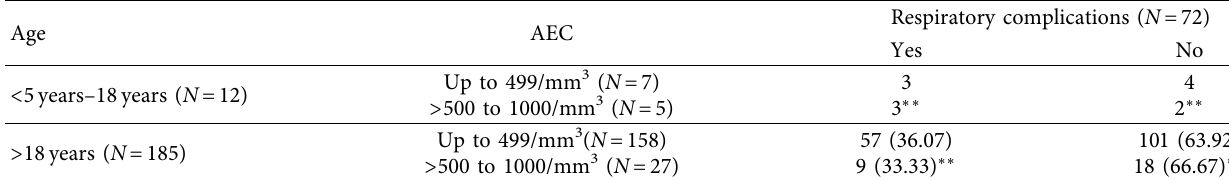
Table 2: Relationship between diferent age groups and adverse respiratory